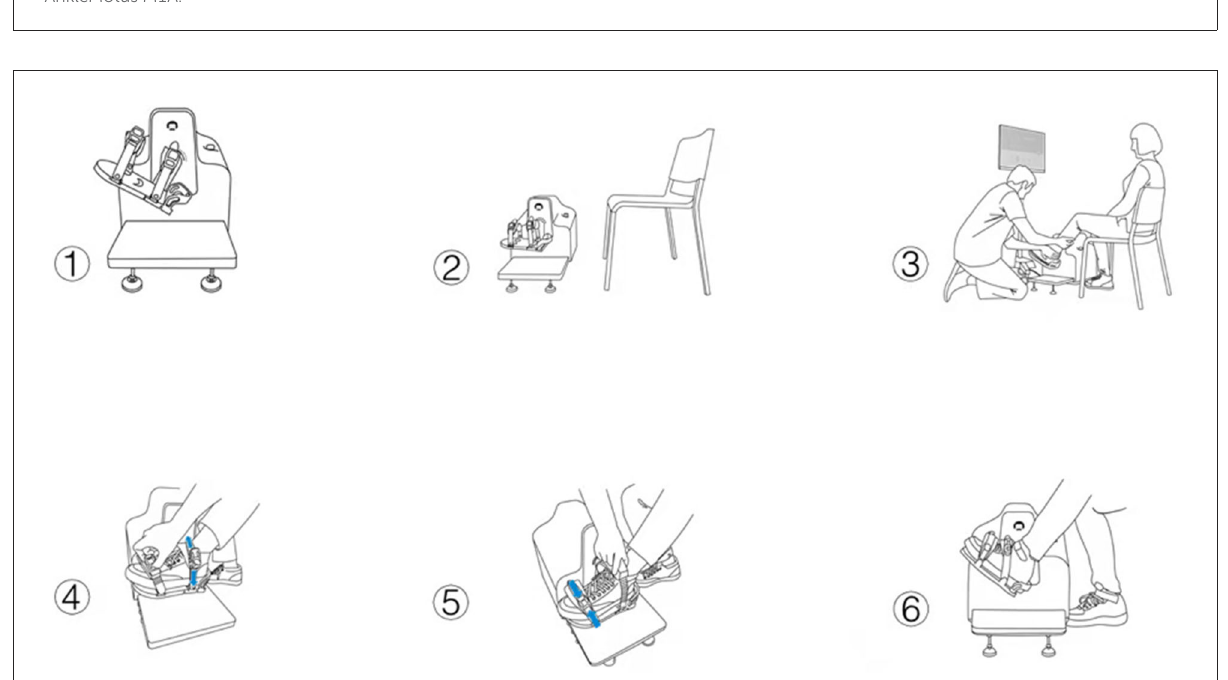
FIGURE3 The procedures for the training position.